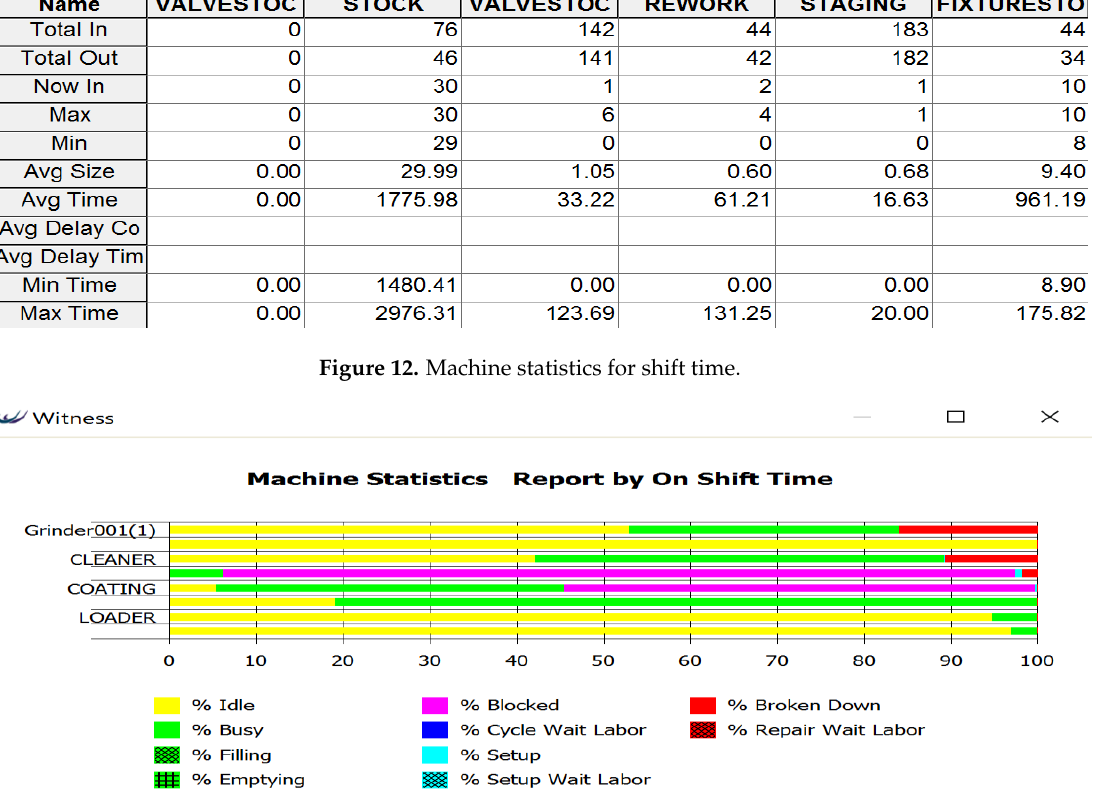
Figure 13. Chart statistics for shift time.